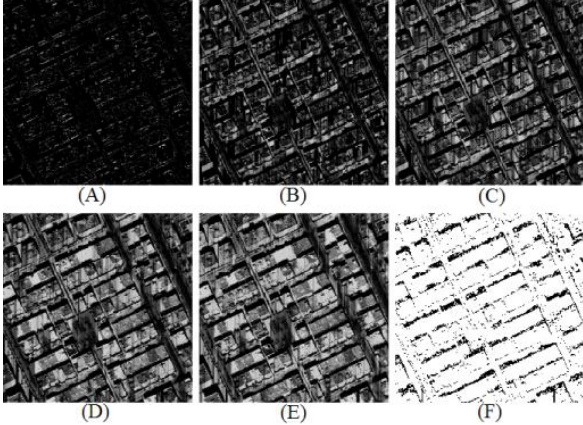
Figure 2. Subtraction of main image from reconstructed image by a SE with 90 degree direction and a scale of, A. 5×5, B. 10×10, C. 15×15, D. 20×20, E. 25×25. F. Summation of A to E